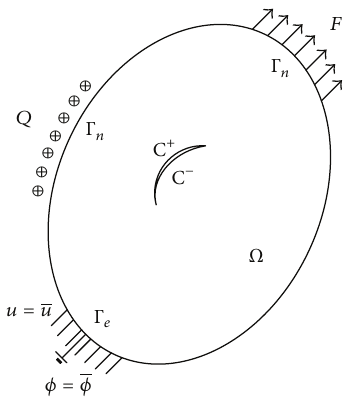
Figure 1: Piezoelectric domain with a